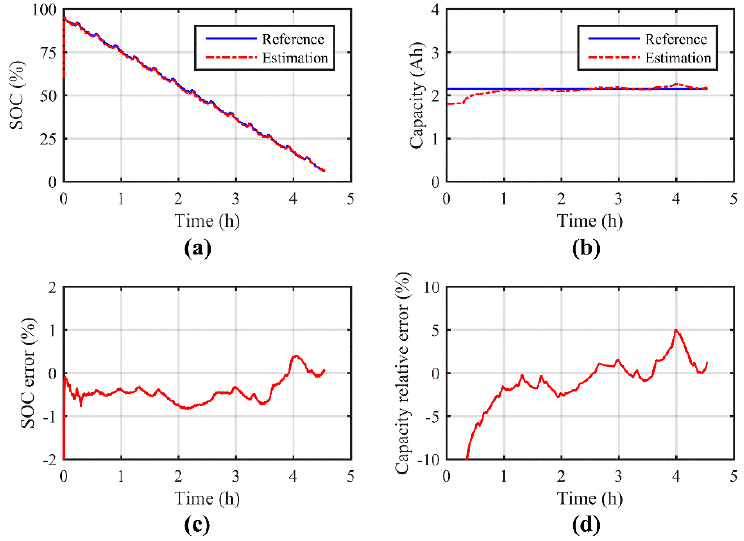
Figure 9. Estimation results of SOC and capacity for the experimental study: ( a ) estimation of SOC; ( b ) estimation of capacity; ( c ) error of SOC estimation; ( d ) relative error of capacity estimation. Table 4. Algorithmic performance on SOC and capacity estimation for the experimental study. Measure